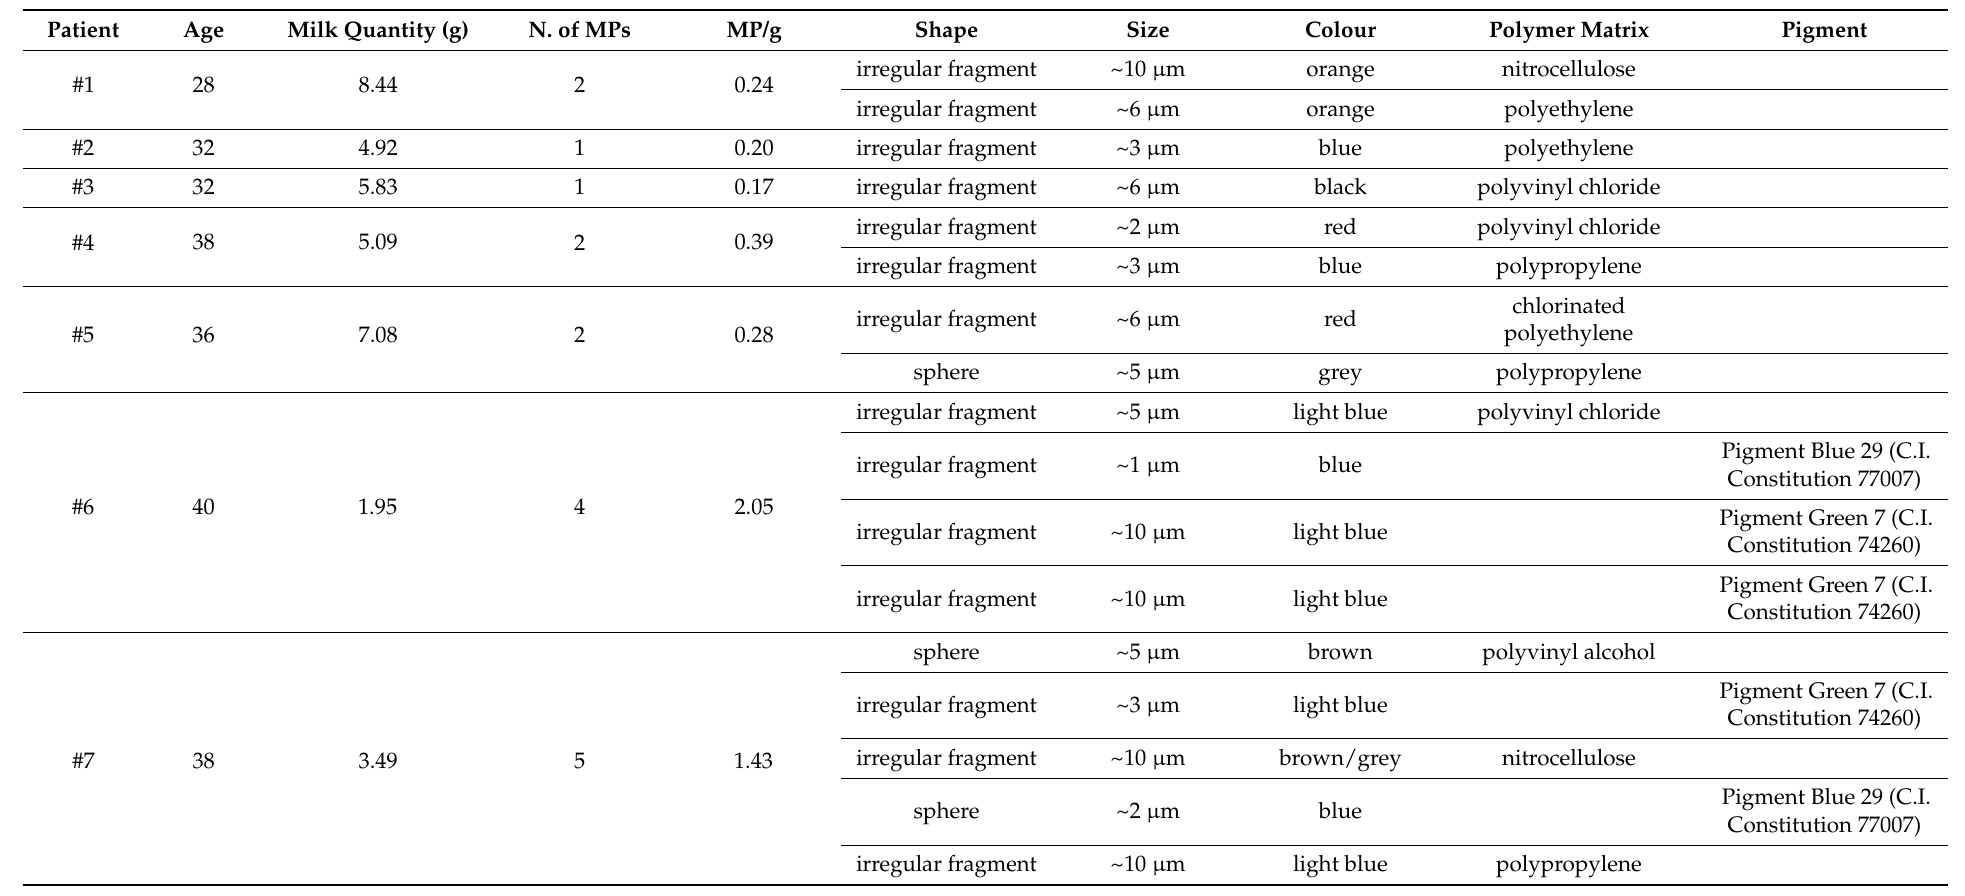
Table 1. Information about patients (age, quantity of milk sample, and abundance of MPs) and morphological and chemical features of the identified